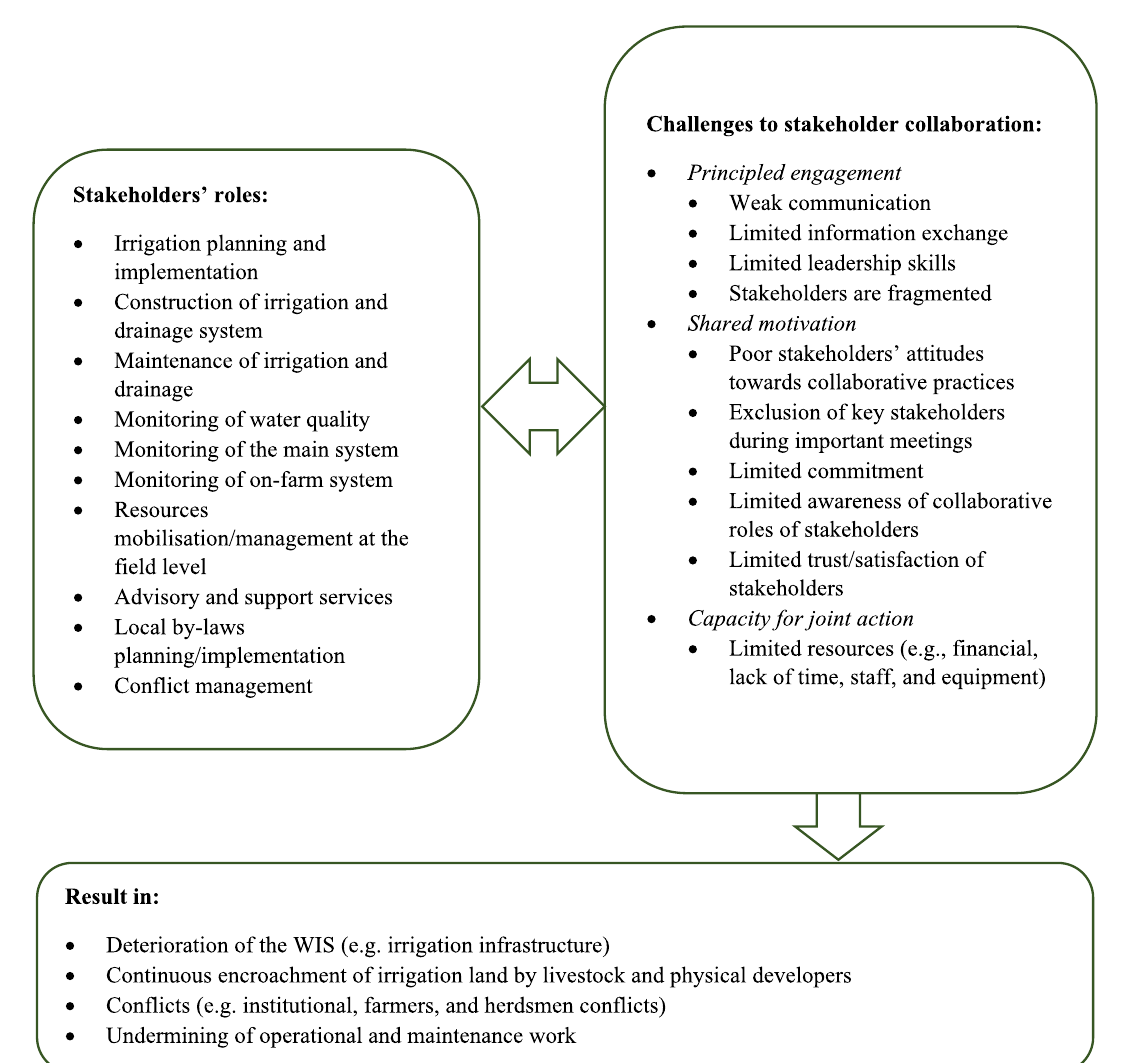
Fig. 3 List of themes according to stakeholders’ roles, challenges to stakeholder collaboration, and their effect. Source: Developed by the authors, based on the results of this